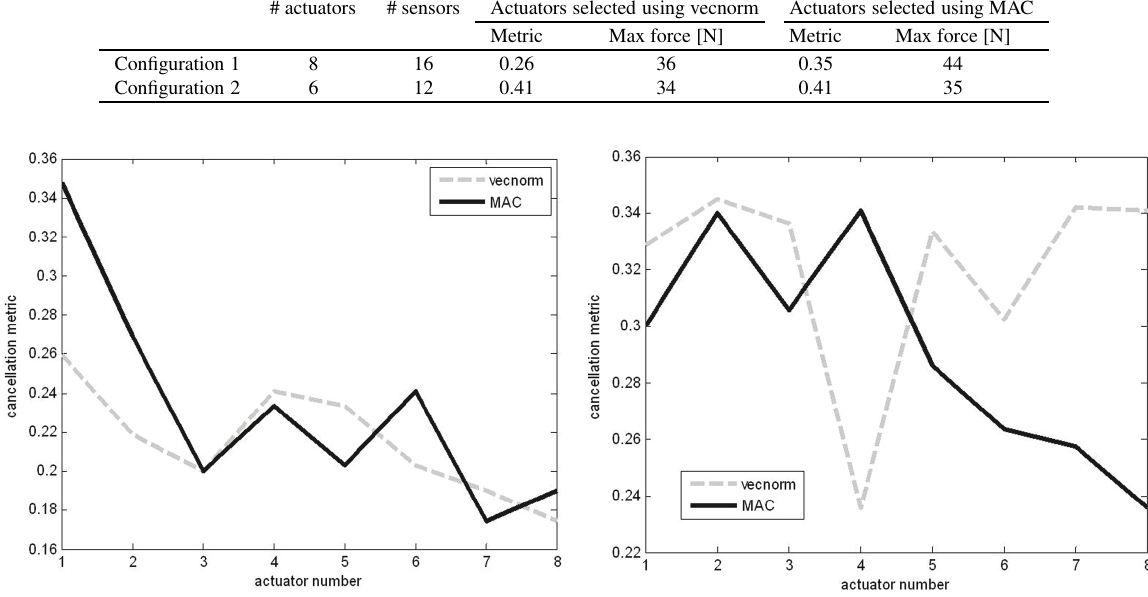
Fig. 5. Performance metric comparison of the top 8 actuator positions using the vector normalization and MAC approaches with error sensors in region 1 (sidewall